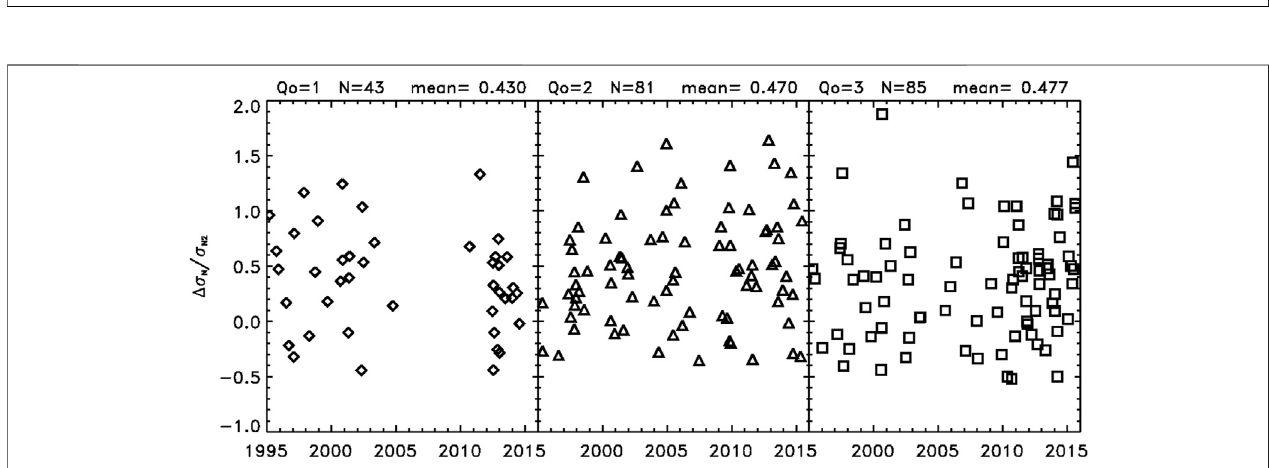
FIGURE2| Aplot of Δσ N / σ N2 versus time for thefamily of Q 0 , showing almost thesame averageof Δσ N / σ N2 for each Q 0 (the averages are givenabove each panel), where Q 0 (cid:1) 1 set is represented by diamonds, Q 0 (cid:1) 2 by triangles, and Q 0 (cid:1) 3 by squares, with a large spread in values in each